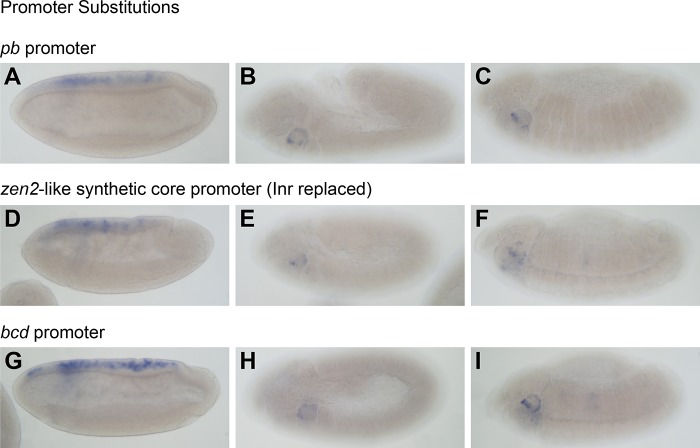
Modifying the reporter promoter does not affect expression pattern driven by EO053.See also Supplementary file 3 for promoter sequences. Replacement of the Drosophila Synthetic Core Promoter (DSCP) in the reporter vector pBPGUw with either the pb promoter (A–C), a replacement of the DSCP Initiator sequence with that from zen2 (D–F), or the promoter from bcd (G–I). GAL4 mRNA expression from all constructs is shown during the early phase of zen2-like expression (A, D, G) or during later stages of pb-like expression (B, E, H: stage 11–12; C, F, I: stage 13–16).